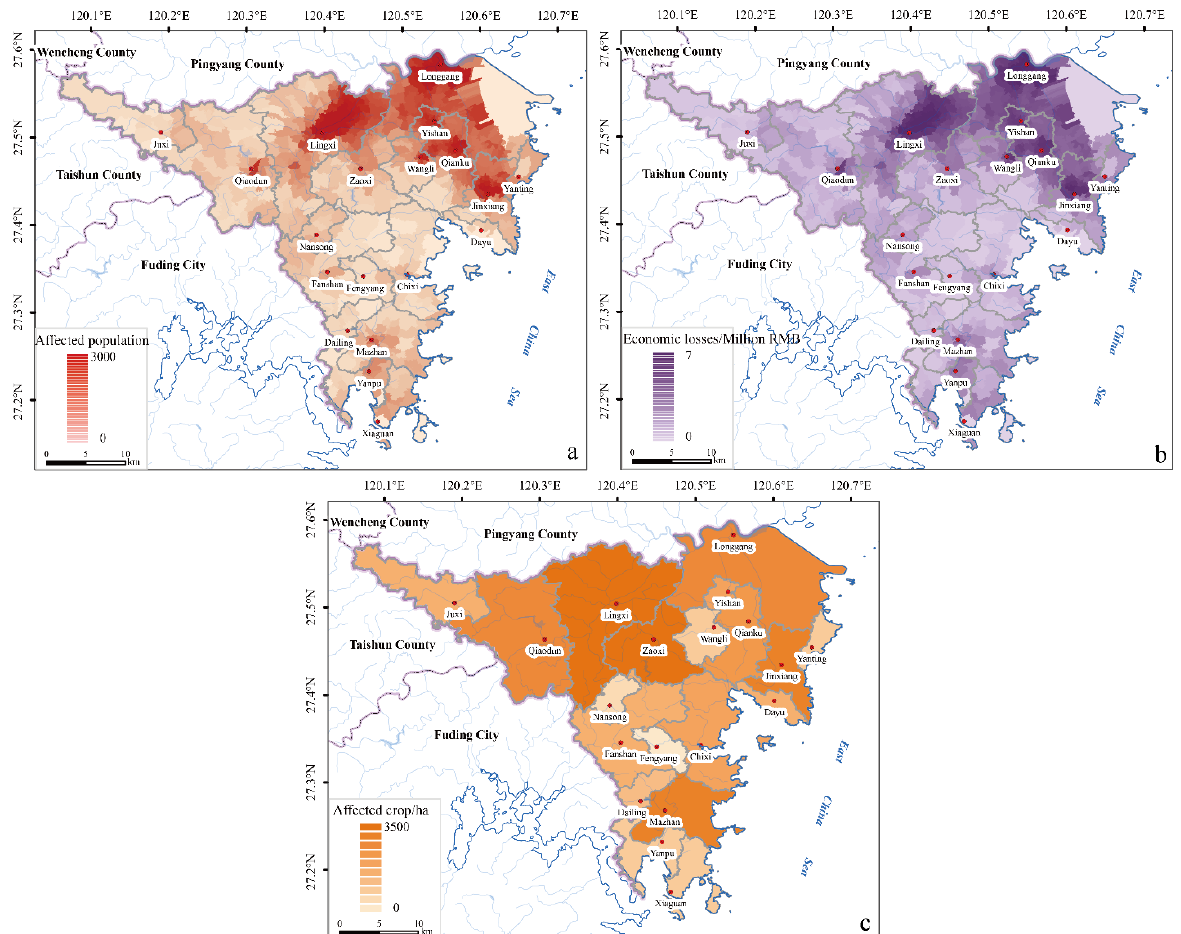
Figure 6. Spatial patterns of severe drought risk in Cangnan County: ( a ) population, ( b ) economy, and ( c ) crops.